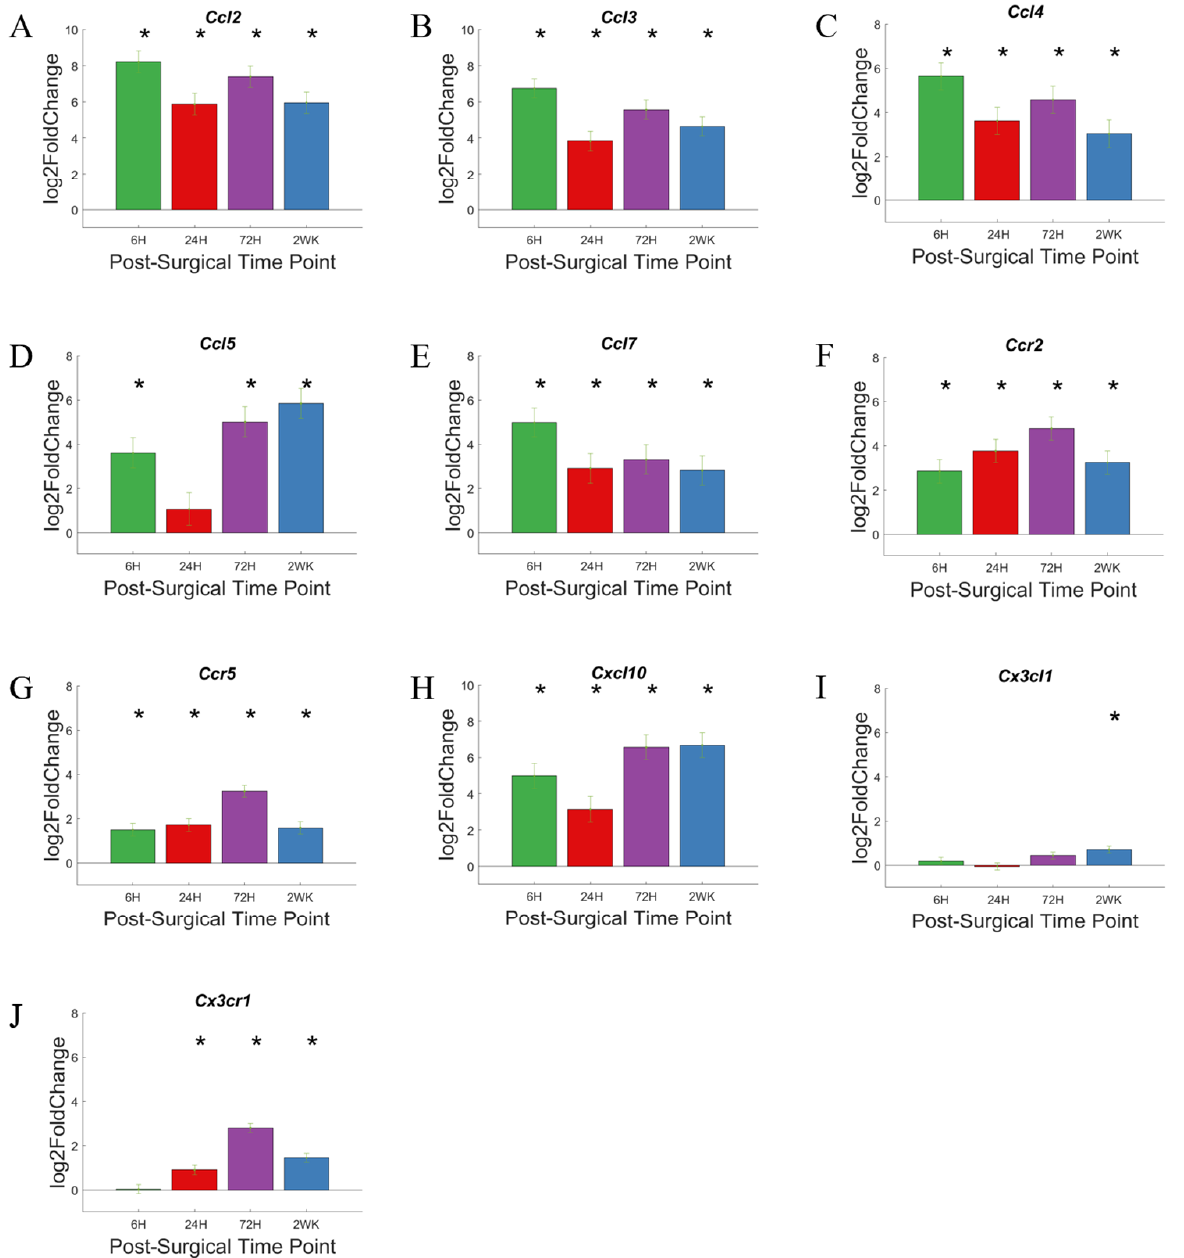
Figure 12. Differential expression of specific genes involved in the chemokine pathway compared to NSCTR mice: ( A – J ) Top differentially expressed genes for the chemokine gene set displayed as bar graphs of individual genes as a function of time post-surgery. For each time point, gene expression levels are compared to the NSCTR mice. Error bars indicate the standard error of the mean between NSCTR and each time point. Asterisks indicate that P adj < 0.05. Note ( A , B , H ), which depicts the upregulation of Ccl2 , Ccl3 , and Cxcl10 , respectively, has a y-axis log2foldchange scale of − 1 to 10, because of their high